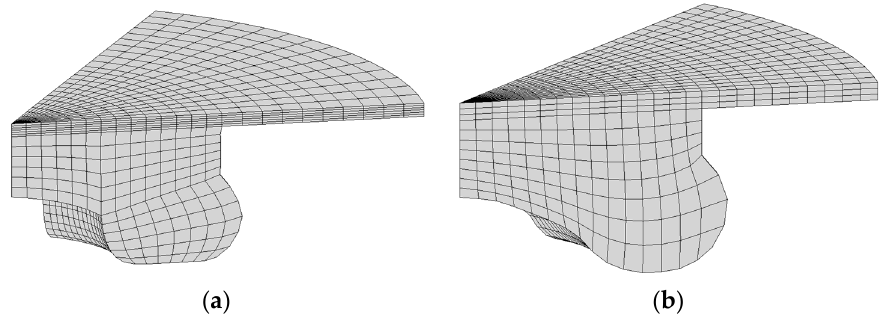
Figure 1 . Generated grids at TDC: ( a ) HCCI engine, ( b ) CCI engine. Figure 1. Generated grids at TDC: ( a ) HCCI engine, ( b ) CCI